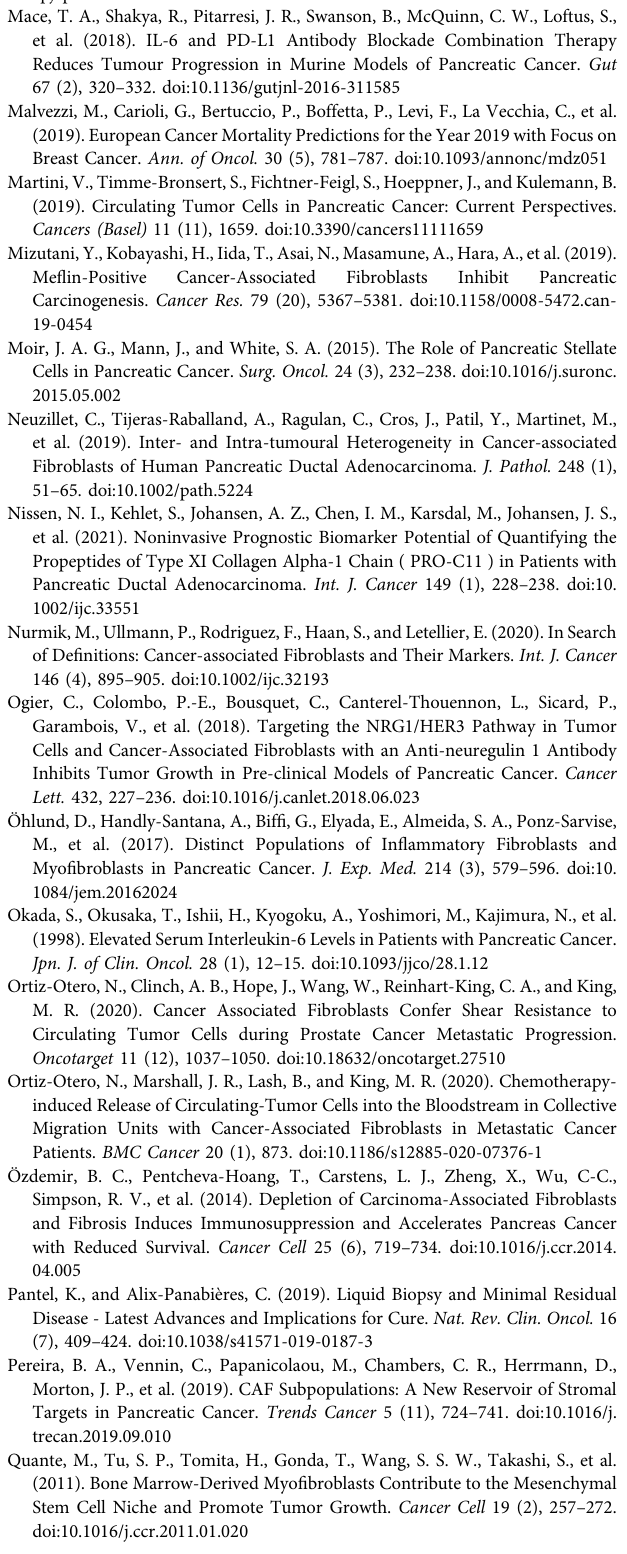
Alliance: Figure 1. Cancer Res. 68 (19), 7707 – 7710. doi:10.1158/0008-5472.